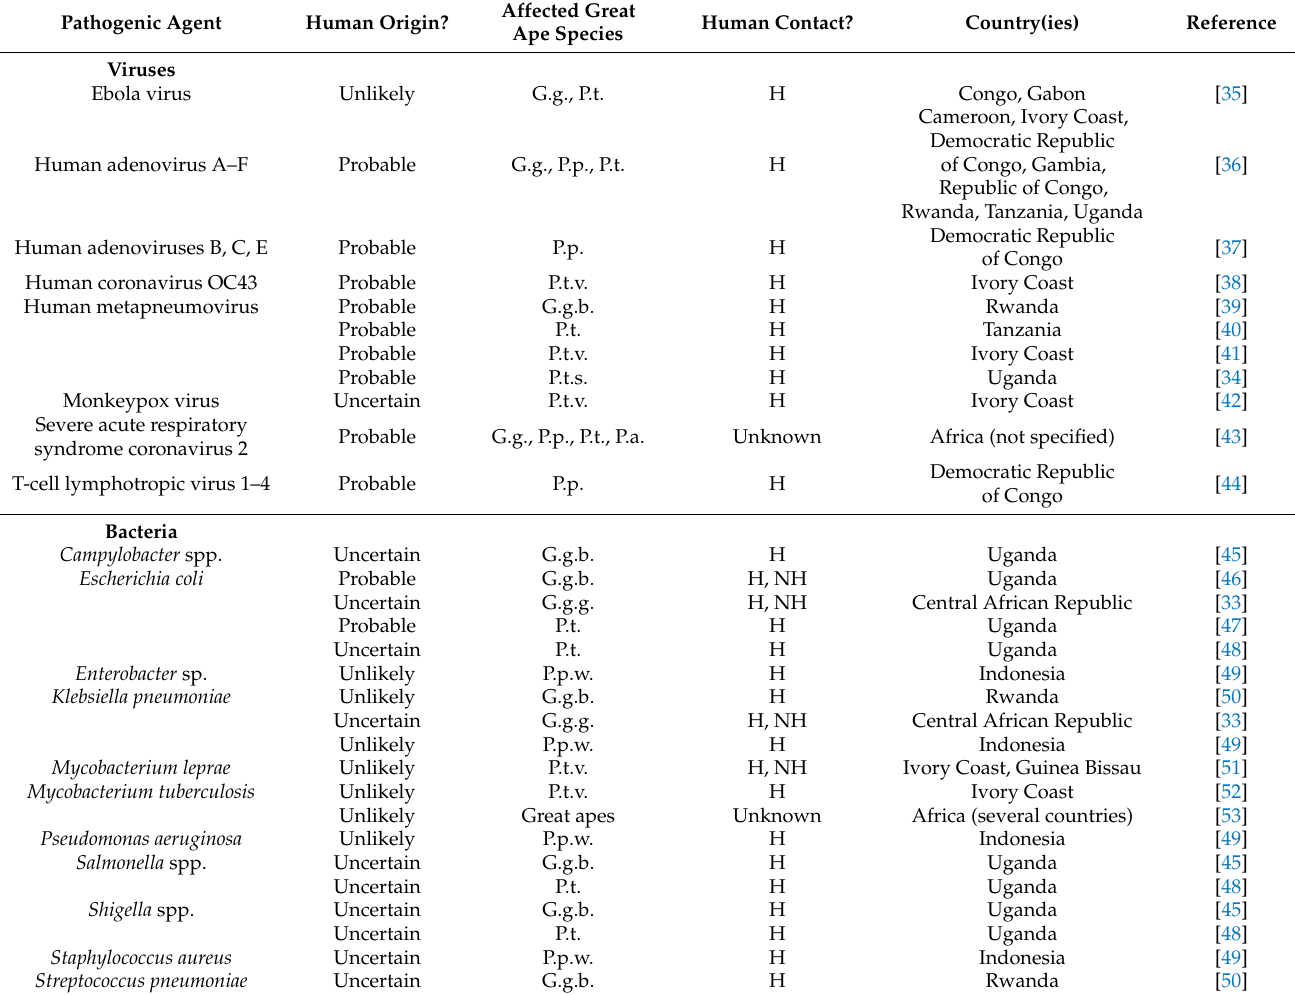
Table 1. Pathogens of viral, bacterial, parasitic, and fungal nature for which reverse zoonotic trans- mission from humans to wild great apes is